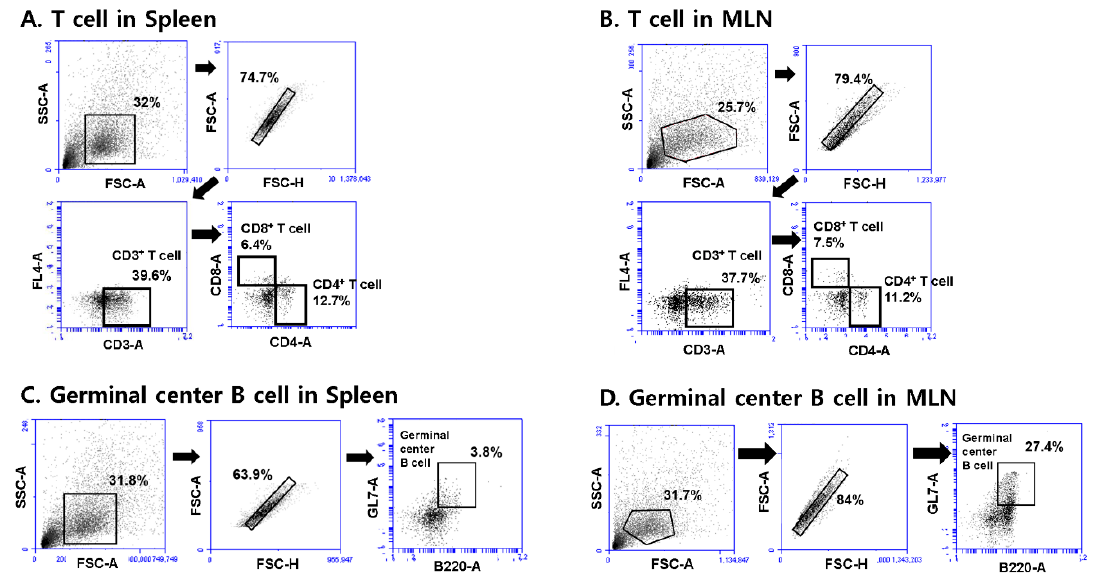
Figure 5. The gating strategy of CD4 + , CD8 + T cell and germinal center B cell in spleen and MLN cells. Spleen and MLN cells from mice ( n = 5) were collected at day 30 upon challenge infection with T. gondii ME49 and stained with phenotype-specific marker antibodies (CD3, CD4, CD8, B220, GL7). CD4 + , CD8 + T cell gating strategy in spleen cells ( A ). CD4 + , CD8 + T cell gating strategy in MLN cells ( B ). Germinal center B cell gating strategy in spleen cells ( C ). Germinal center B cell gating strategy in MLN cells ( D ).